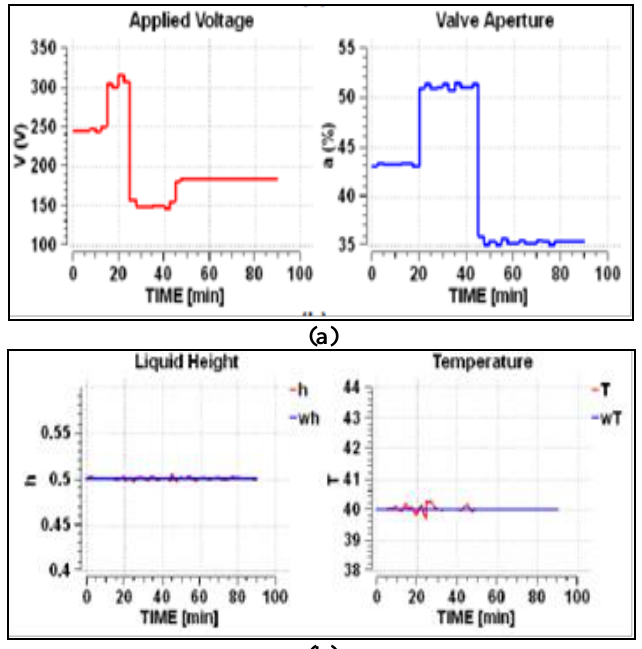
Figure 5: (a) Manipulated and (b) controlled variables.